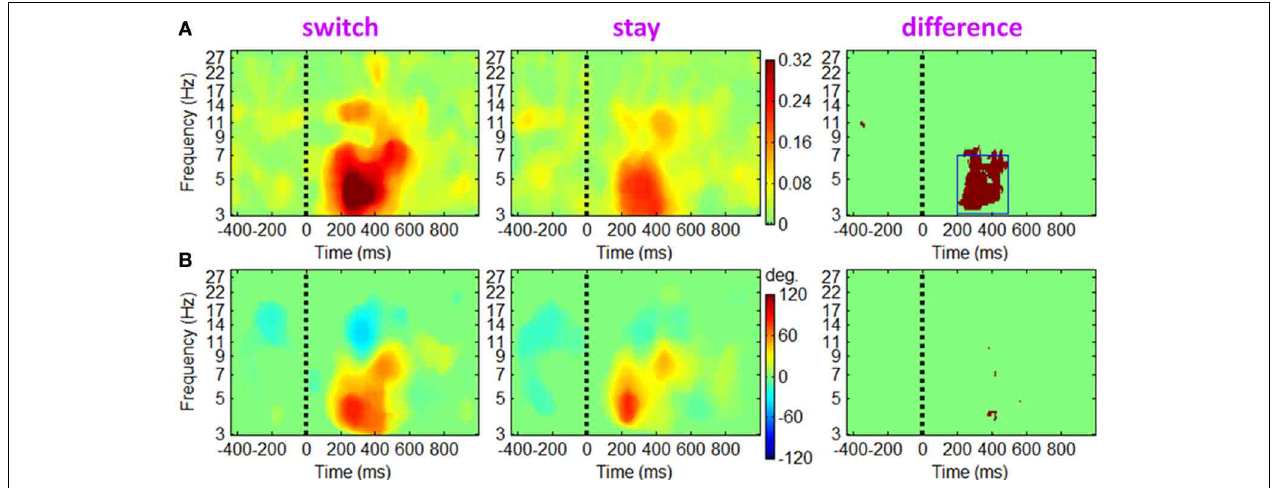
FIGURE 9 | The ERCOH measurements between fronto-central theta and the left mu IC clusters. (A) The phase cross-coherence magnitude. Colors show significant ERCOH magnitude between the two IC clusters ( p < 0 . 01). The dark red region in the third column shows significant